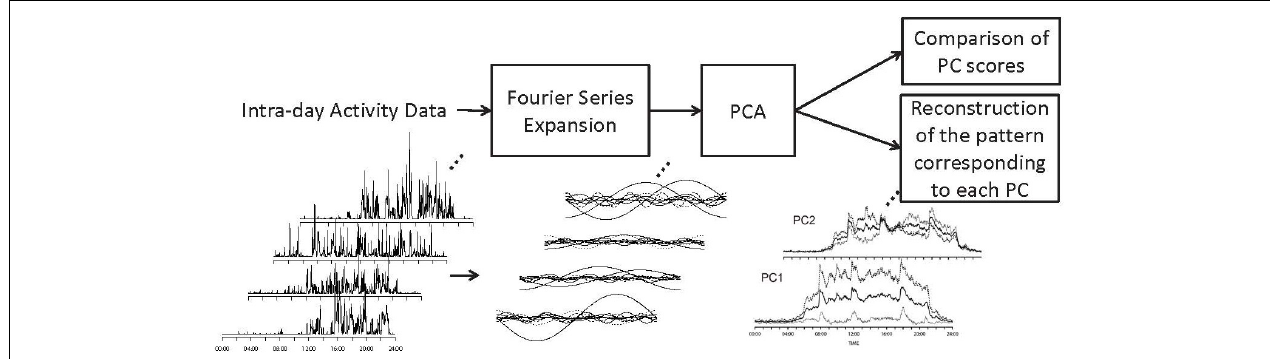
FIGURE 1 | The framework of the study. Fourier series expansion was performed on each intraday activity sequence. PCA was performed on the coefficients of Fourier expansion. The waveforms corresponding to –1SD and +1SD of theoretical values along each PC were calculated based on the differences in Fourier coefficients along each